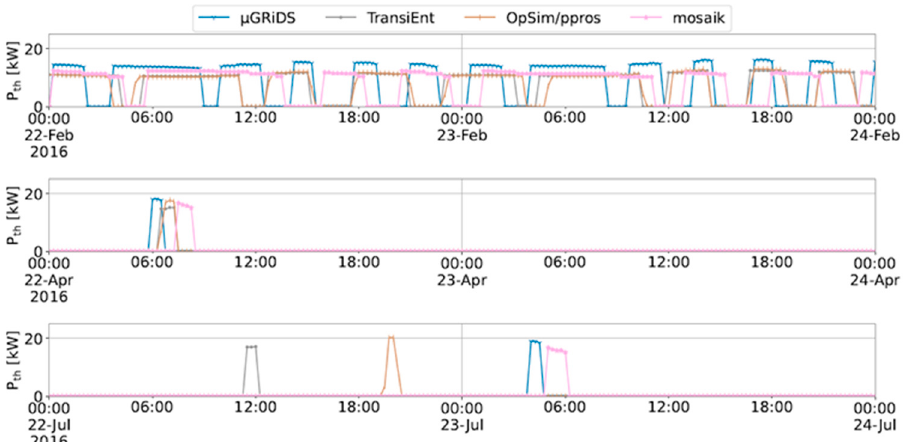
Figure 7. Thermal output of the HP for two days in February (winter), April (transition) and July (summer). Compared are the different results among the four models involved.